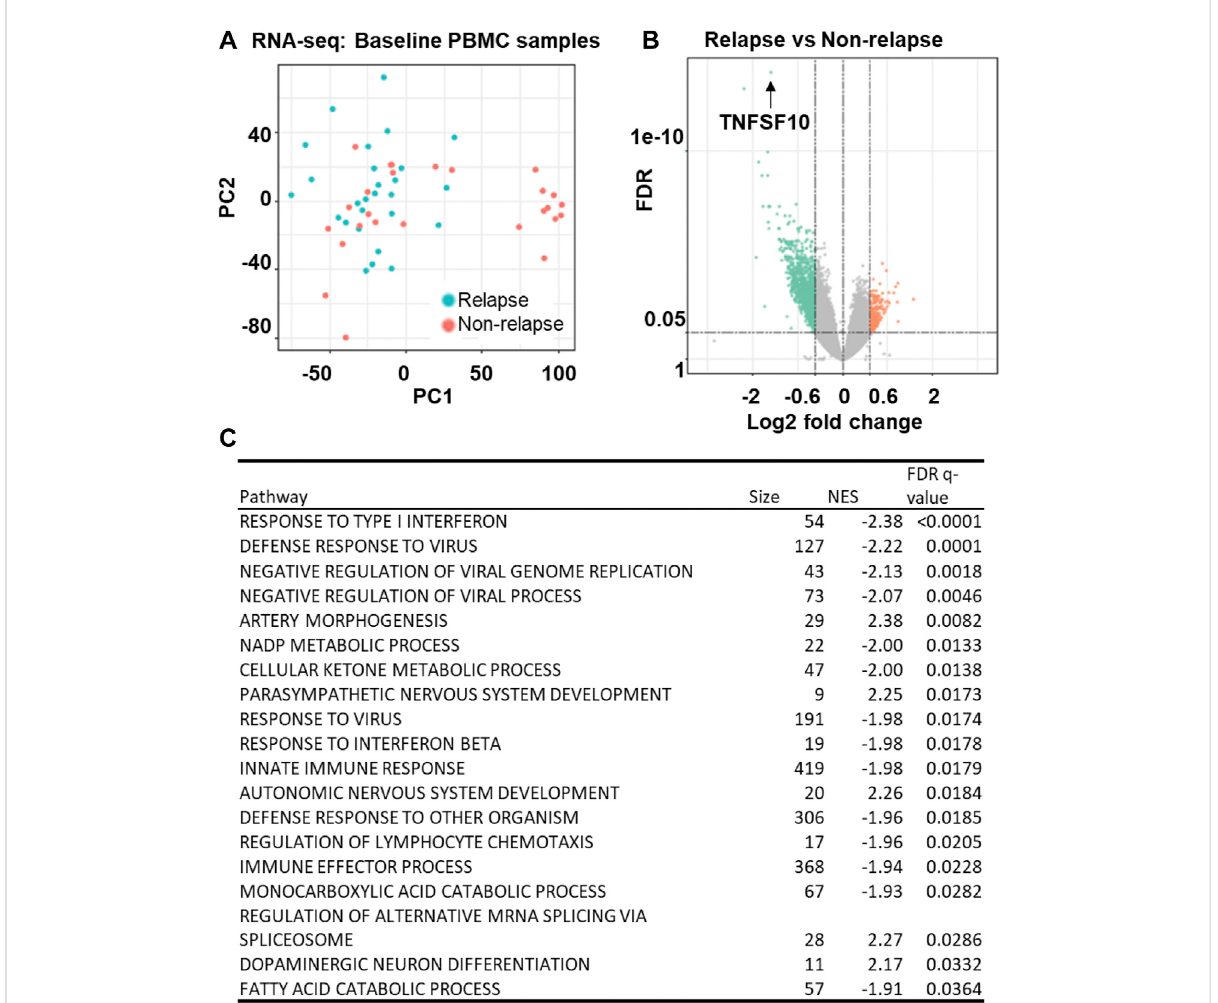
FIGURE 4 Gene expression pro fi les in baseline PBMC sample from AUD patients. (A) Principal components analysis (PCA) of gene expression pro fi les in PBMCs obtained at baseline from AUD patients (relapse: n = 27, non-relapse: n = 26). Relapse was de fi ned as taking one drink during 3 months of acamprosate treatment, while non-relapse was de fi ned as remaining abstinent during 3 months of acamprosate treatment. (B) A volcano plot showingexpressionpro fi lesfor themostdifferentiallyexpressedgenesbetweentherelapse andnon-relapse groupsbasedon thePBMC RNA- seq data (FDR < 0.05). (C) Pathway analysis of the PBMC RNA-seq data was performed using gene set enrichment analysis (GSEA) software (Mootha et al., 2003; Subramanian et al., 2005). NES is the normalized enrichment score to account for the size of each gene